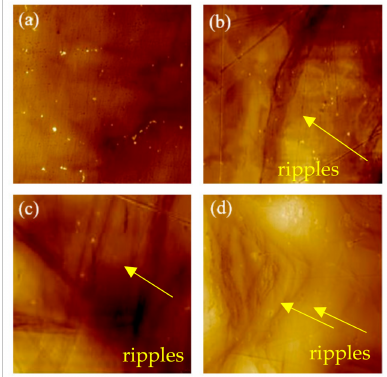
Figure 3. Local special surface morphology of specimen after WLSP: ( a ) 250 ◦ C, 3 J, 1 time, spot overlap rate of 50%; ( b ) 250 ◦ C, 3 J, 4 times, spot overlap rate of 50%; ( c ) 250 ◦ C, 5 J, 1 time, spot overlap rate of 50%; ( d ) 250 ◦ C, 5 J, 4 times, spot overlap rate of 50%.